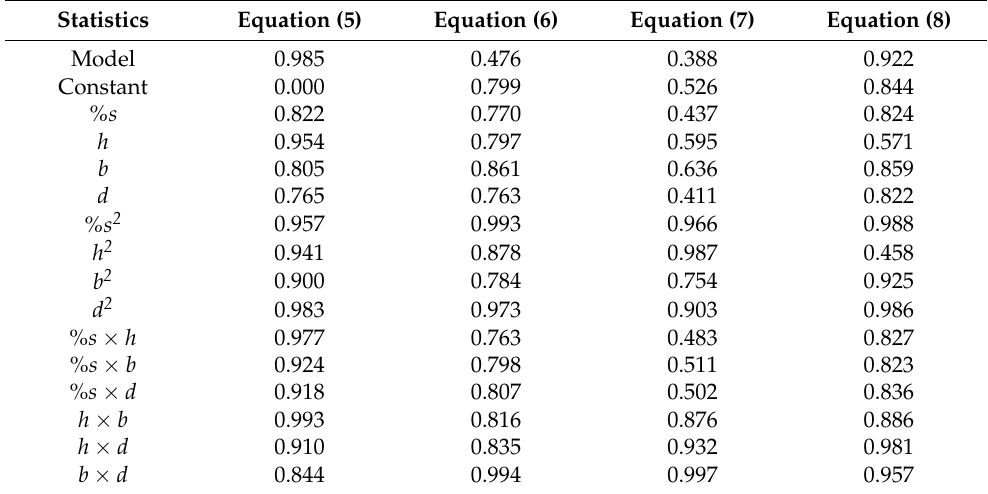
Table 7. ANOVA results ( p -value) of the regression models expressed by Equations